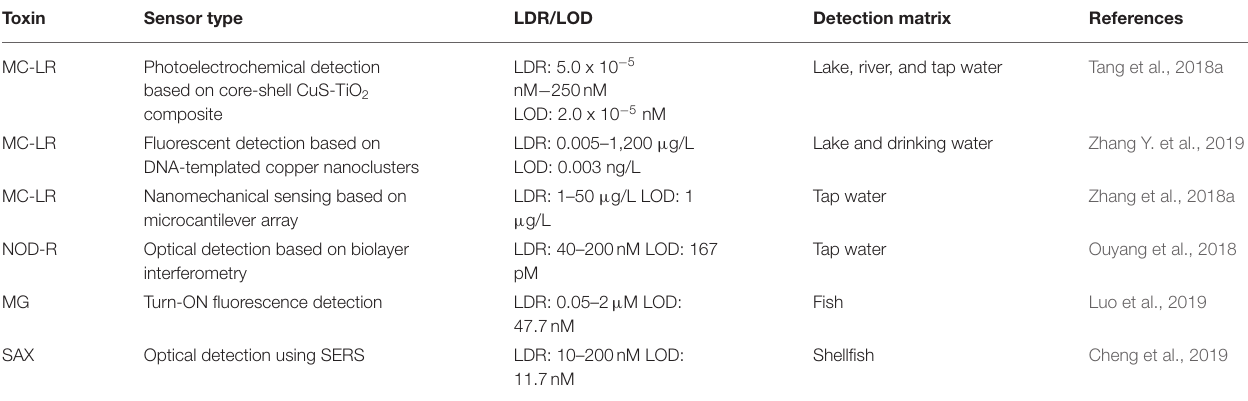
TABLE 1 | Aptamer-based biosensors for the detection of aquatic toxins.